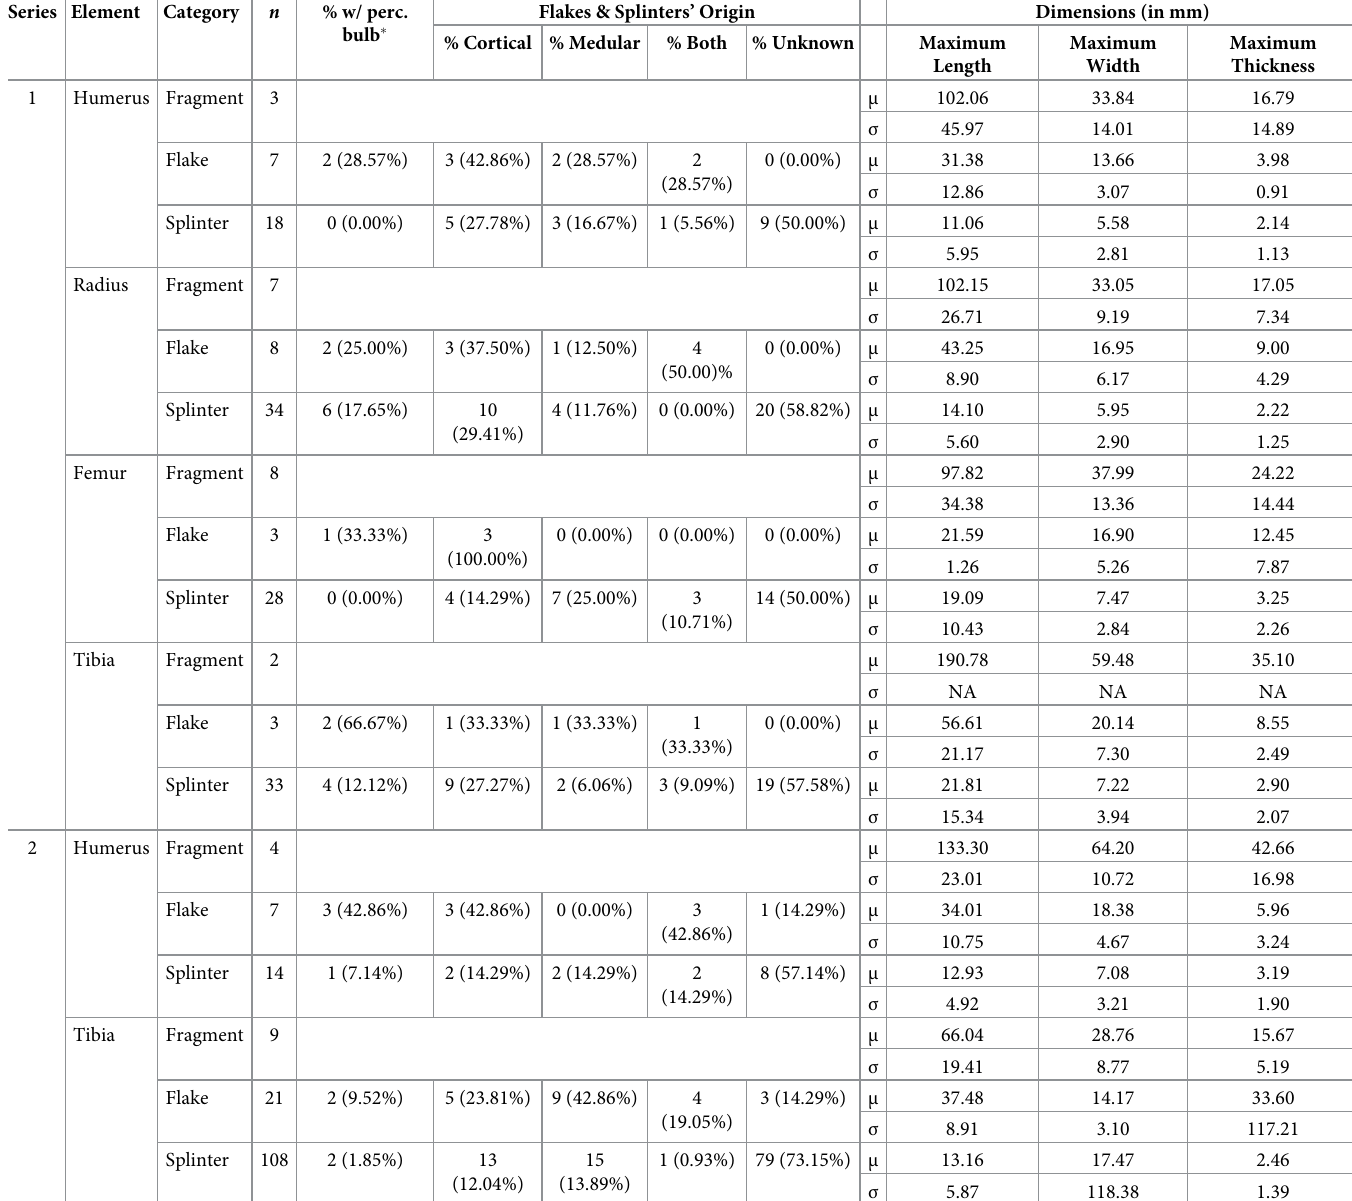
Table 1. Proportion of specimens bearing a percussion bulb, relative frequencies of the origin of fragments, flakes, and splinters, and morphometric data of the remains produced during the experimental marrow extraction on Equus caballus long bones by experimenter. Series Element